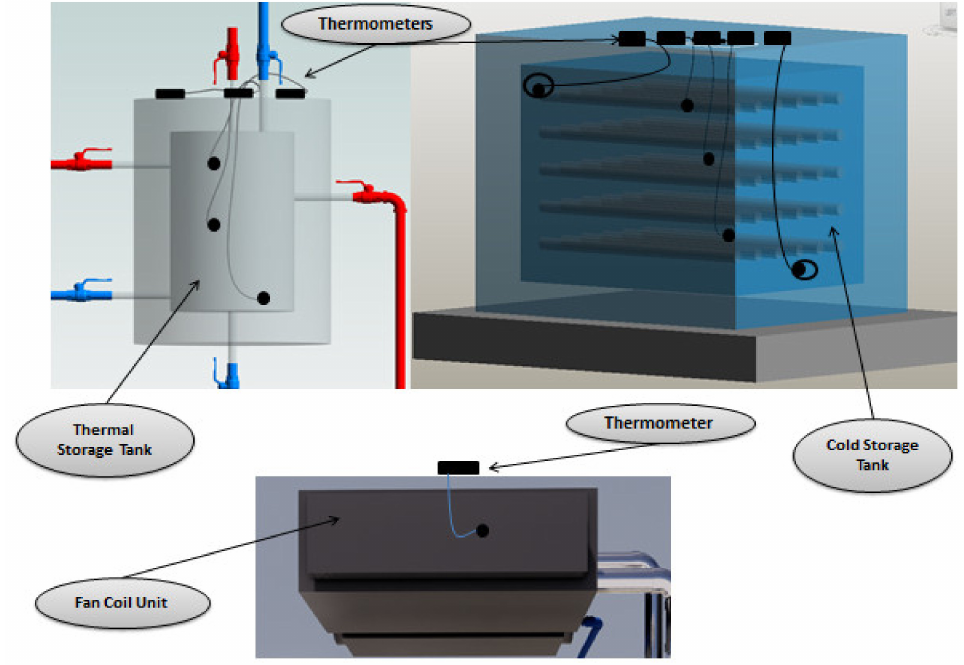
Figure 9. Schematic illustration of the experimental system of the water chiller air-conditioning system integrated with cold and thermal storage